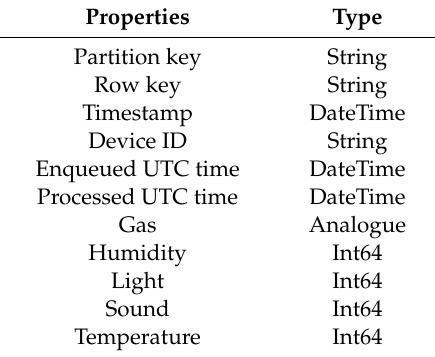
Table 6. Azure Storage Table.